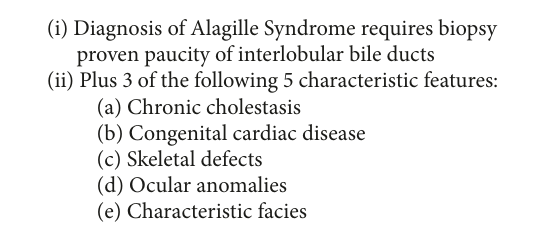
Box 2: Major diagnostic criteria of Alagille Syndrome [2, 4, 7,